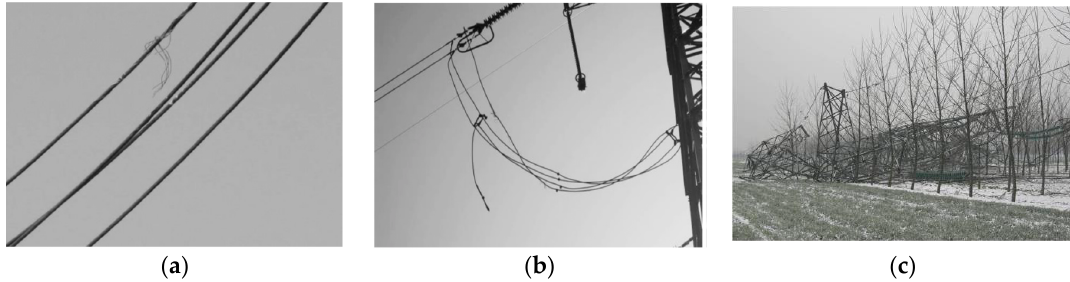
Figure 1. Damages caused by conductor galloping: ( a ) depiction of the damages caused by conductor broken stocks; ( b ) depiction of the damages caused by tension fitting fracture, and suspension clamp breakage; ( c ) depiction of the damages caused by tower collapses.